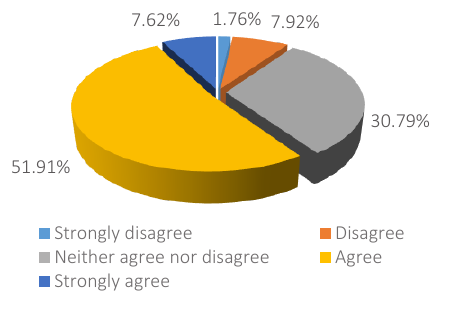
Figure 3b. Opinions on the statement “Dubai Figure 3a. Opinions on the statement “Dubai